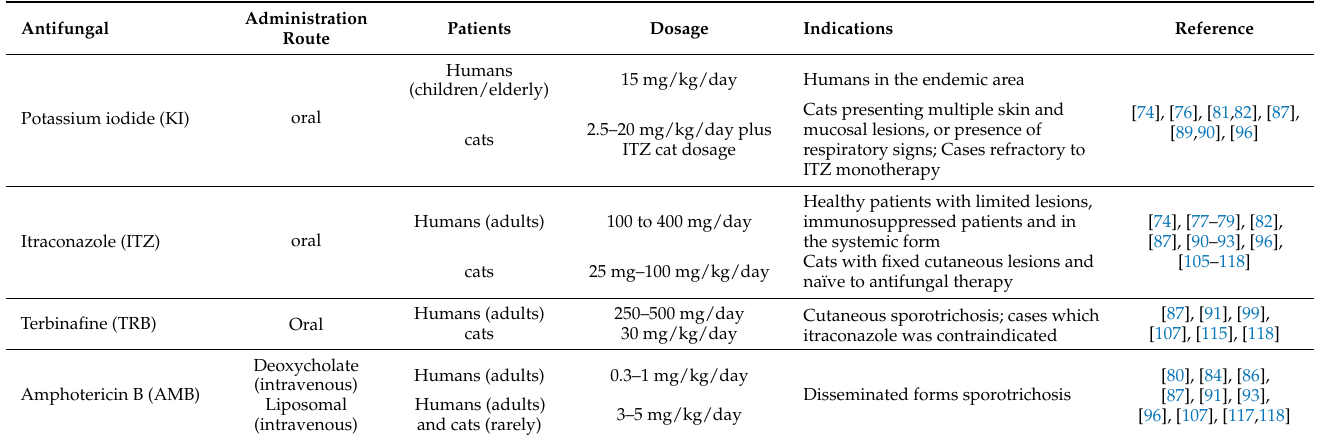
Table 4. Antifungal drugs used for the treatment of